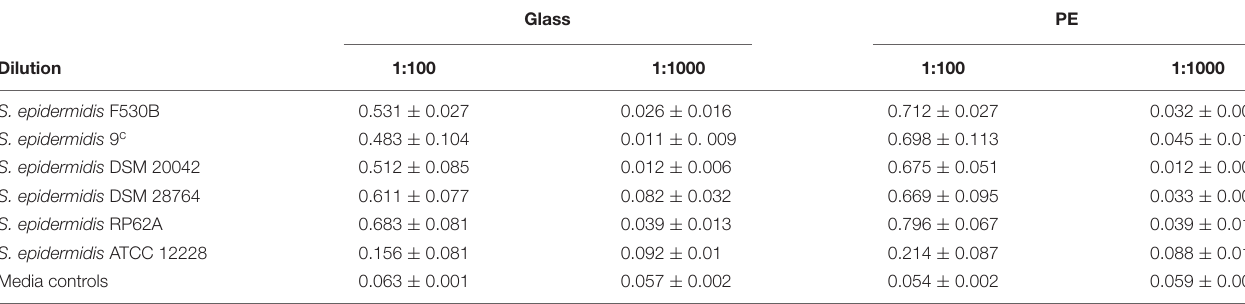
TABLE 3 | Biofilm formation of S. epidermidis measured by crystal violet staining on glass and PE.